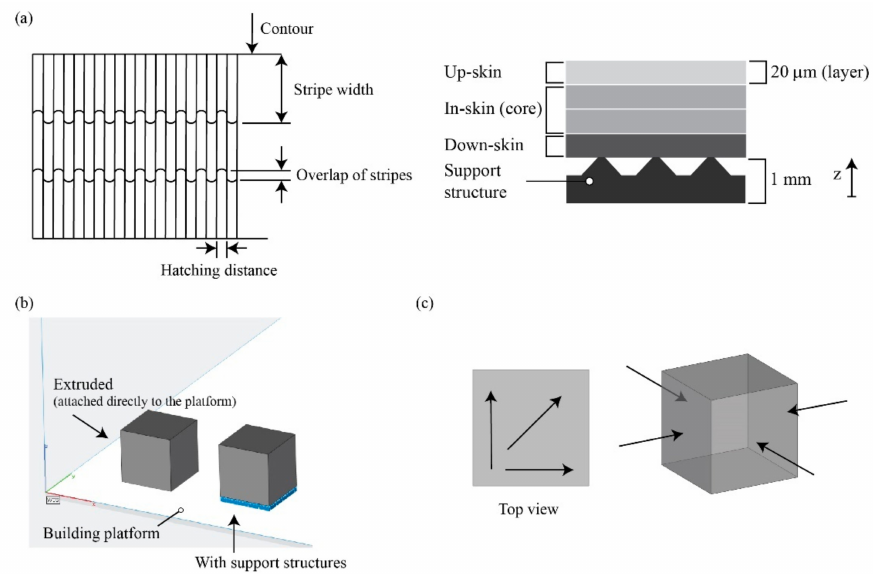
Figure 2. ( a ) Schematic of process parameters; ( b ) manufacturing strategy; ( c ) direction of roughness measurements.